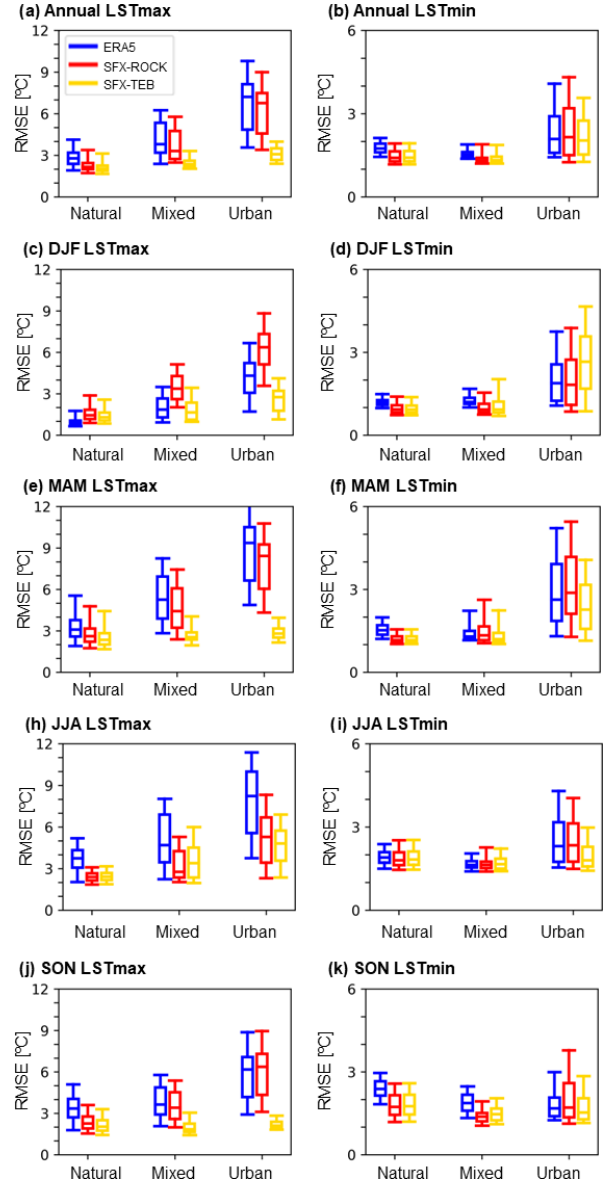
Figure 6. Box plots of the RMSE computed over the 2004–2018 pe- riod from ERA5 (blue), SFX-ROCK (red), and SFX-TEB (yellow) for natural surfaces (grid boxes with urban fraction below 0.33), mixed surfaces (grid boxes with urban fraction between 0.33 and 0.66), and urban surfaces (grid boxes with urban fractions above 0.66). From top to bottom, the rows represent the RMSE computed for the full annual cycle, i.e., DJF, MAM, JJA, and SON. The annual averaged SUHI measured as a difference be- tween the urban and rural station locations under all-sky con- ditions computed from SFX-TEB peaked around 12:00 LT (local time), with a value of + 5 . 0 ◦ C, and reduced through- out the afternoon, stabilizing at a value around + 1 . 5 ◦ C dur- ing the night and morning (Fig. 11f). The inability of